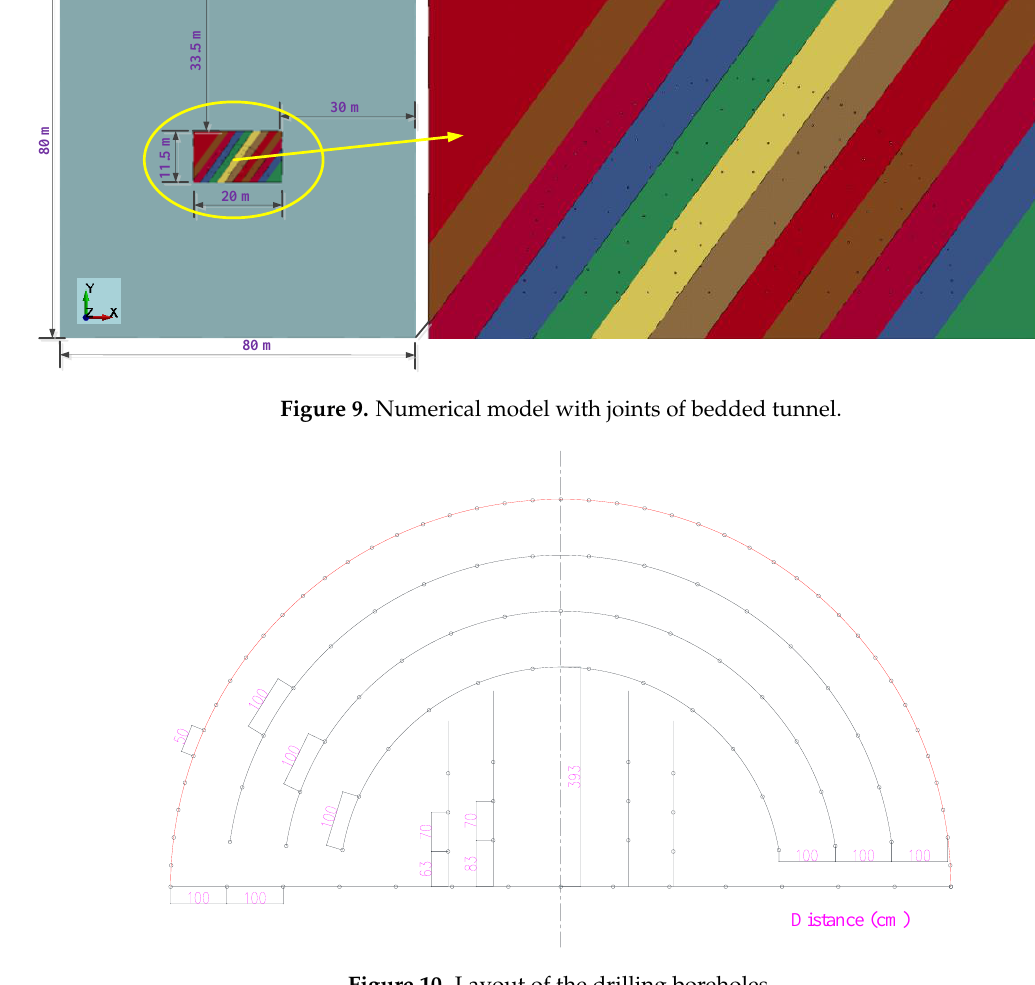
Figure 10. Layout of the drilling boreholes.